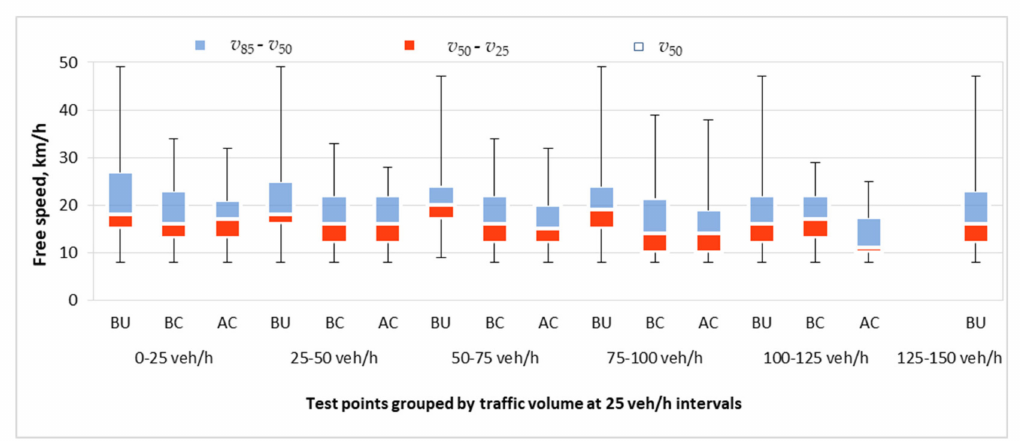
Figure 8. Summary of speed range analysis before and after upgrading, on the approach to and after the choker—data obtained in testing ground No. 1 (BU—before upgrading, BC—before choker, AC—after choker). Source: own work of the author.